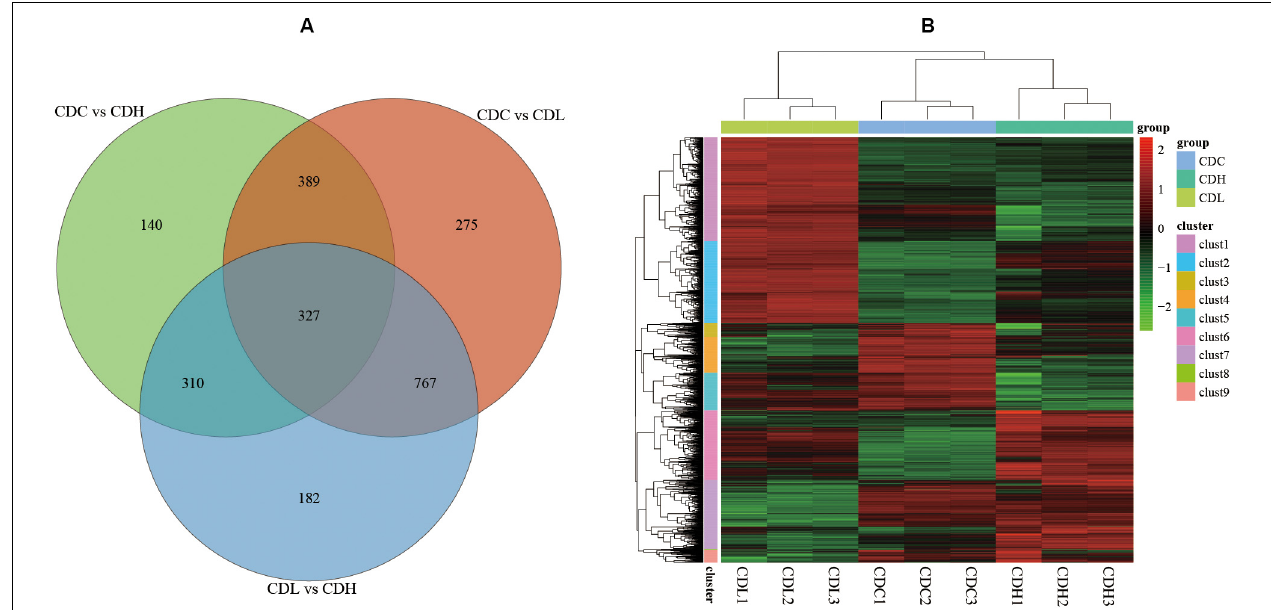
FIGURE 4 | C. difficile transcriptome in different groups. (A) Venn diagram showing the differentially expressed genes that were shared or unique in CDC, CDL, and CDH. (B) Heat map showing clustering of differentially expressed genes in CDC, CDL, and CDH. Red parts represent high expression gene clusters, while green parts represent low expression gene clusters.